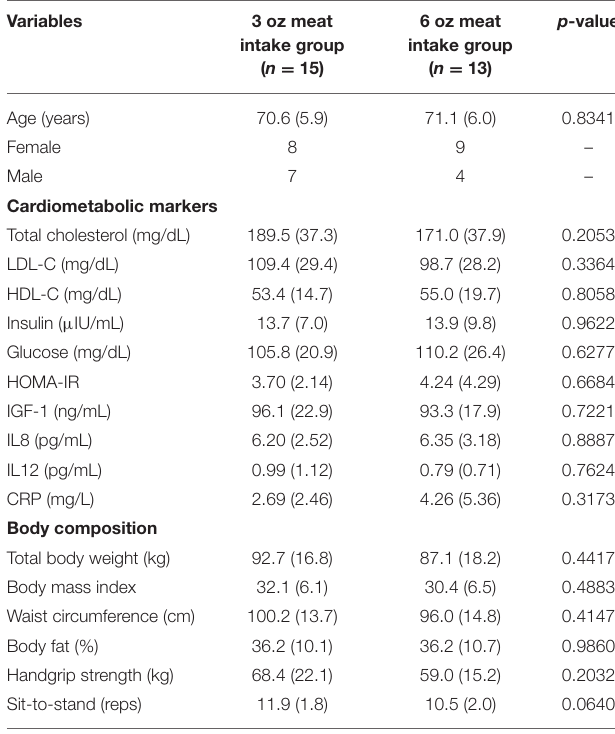
TABLE 1 | Baseline characteristics of study participants separated by meat intake group.